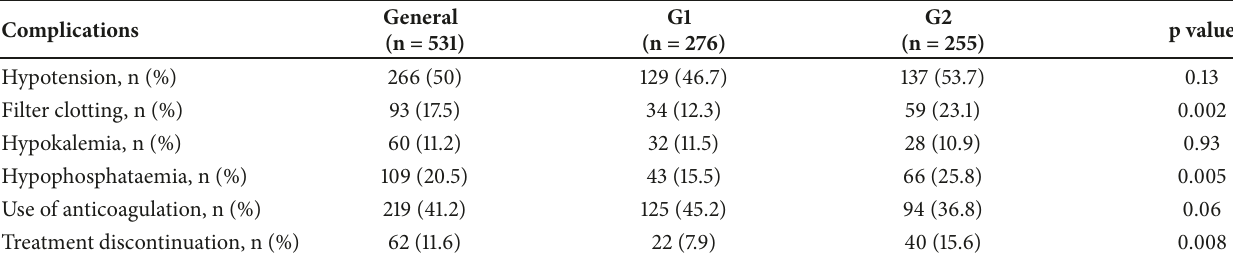
Table 2: Dialysis complications by PHD sessions according to the groups